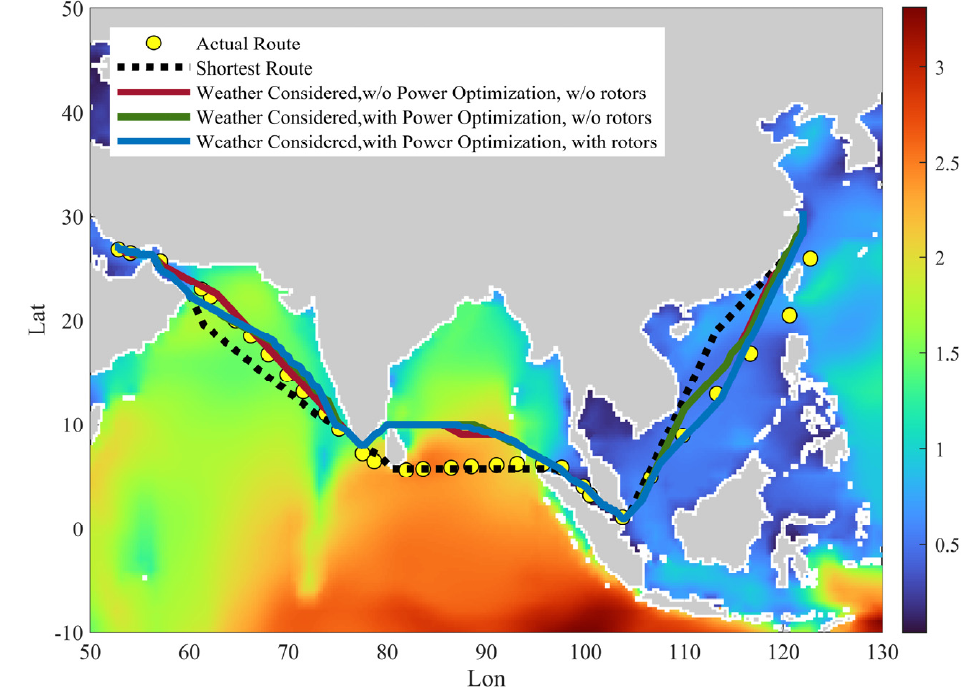
Figure 18. Result for ship weather routing for Case 1.